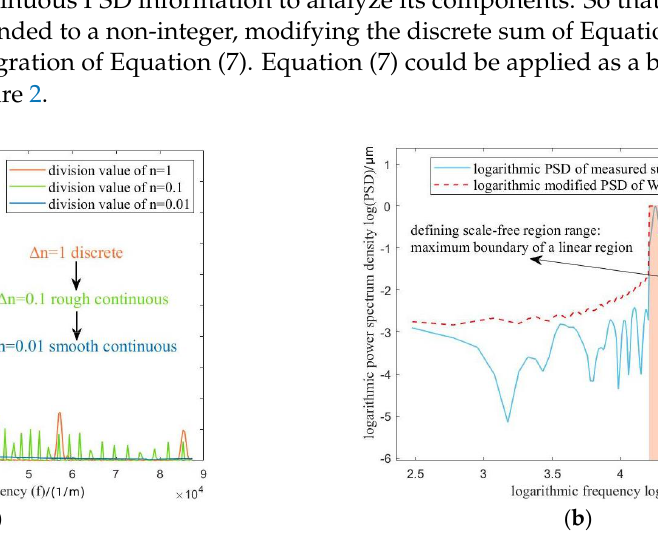
Figure 2. Determination method for the scale-free region based on modified W – M function. ( a ) introduction of non-integer frequency index; ( b ) results in log-log PSD.